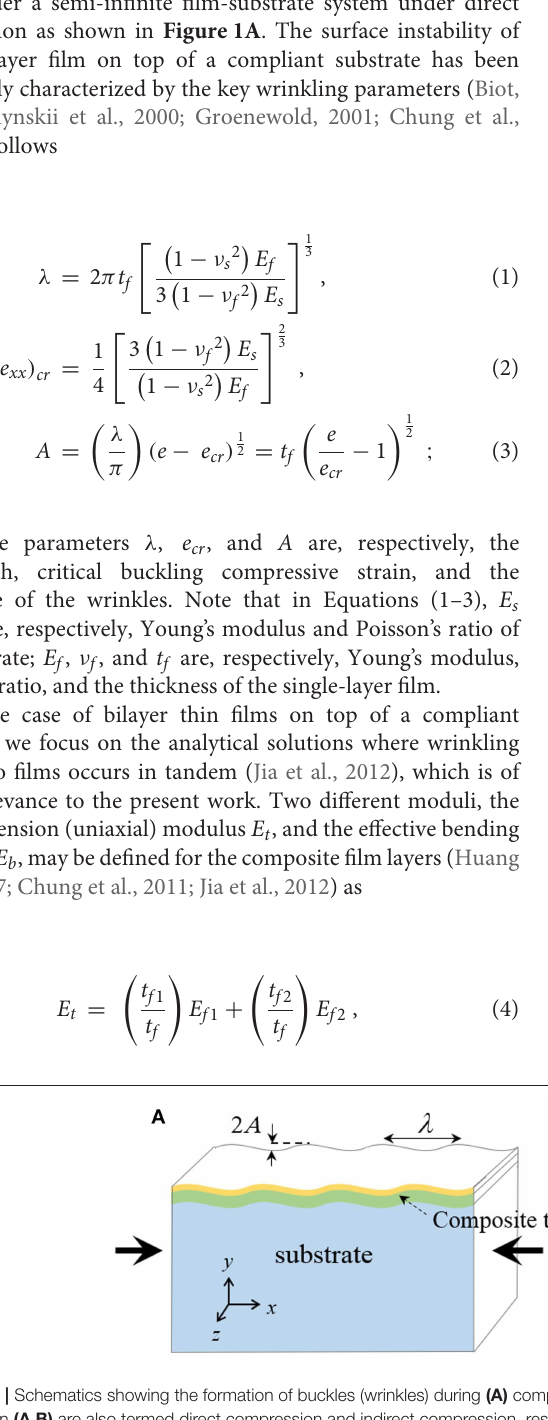
Frontiers in Materials |